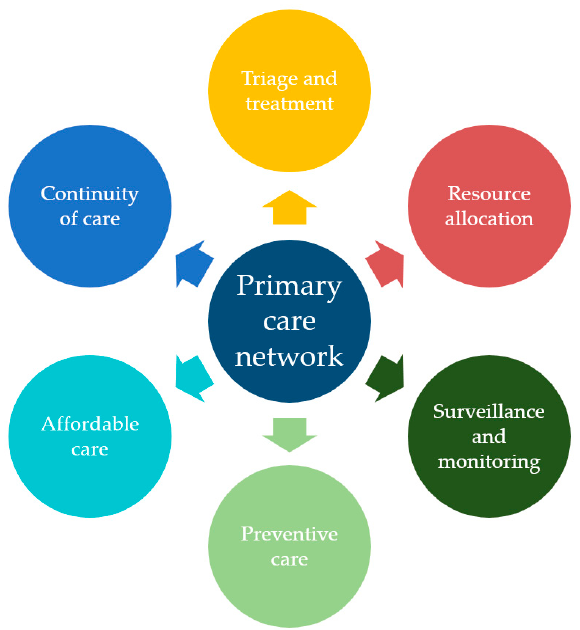
Figure 1. An illustration of the multifaceted role of the primary care network in which general practitioners (GPs) or family physicians operate.